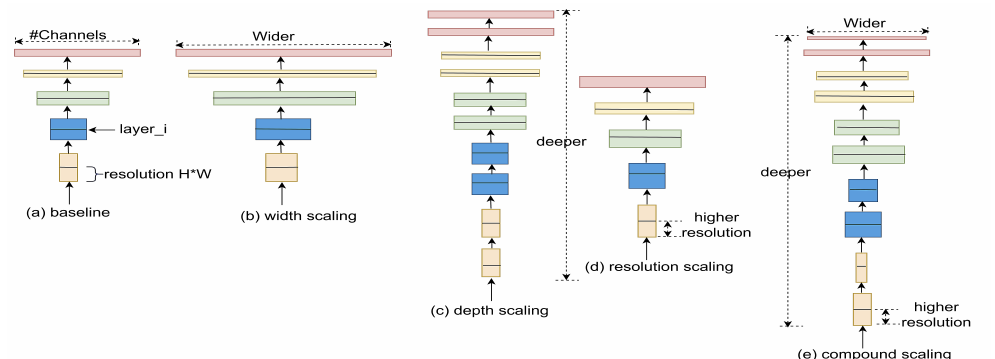
Figure 4. Illustrate model scaling from [29]. ( a ) is a baseline network example; ( b – d ) are conventional scaling that only increases one dimension of network width, depth, or resolution. The compound scaling method ( e ) is the compound scaling method that uniformly scales all three dimensions with a fixed ratio